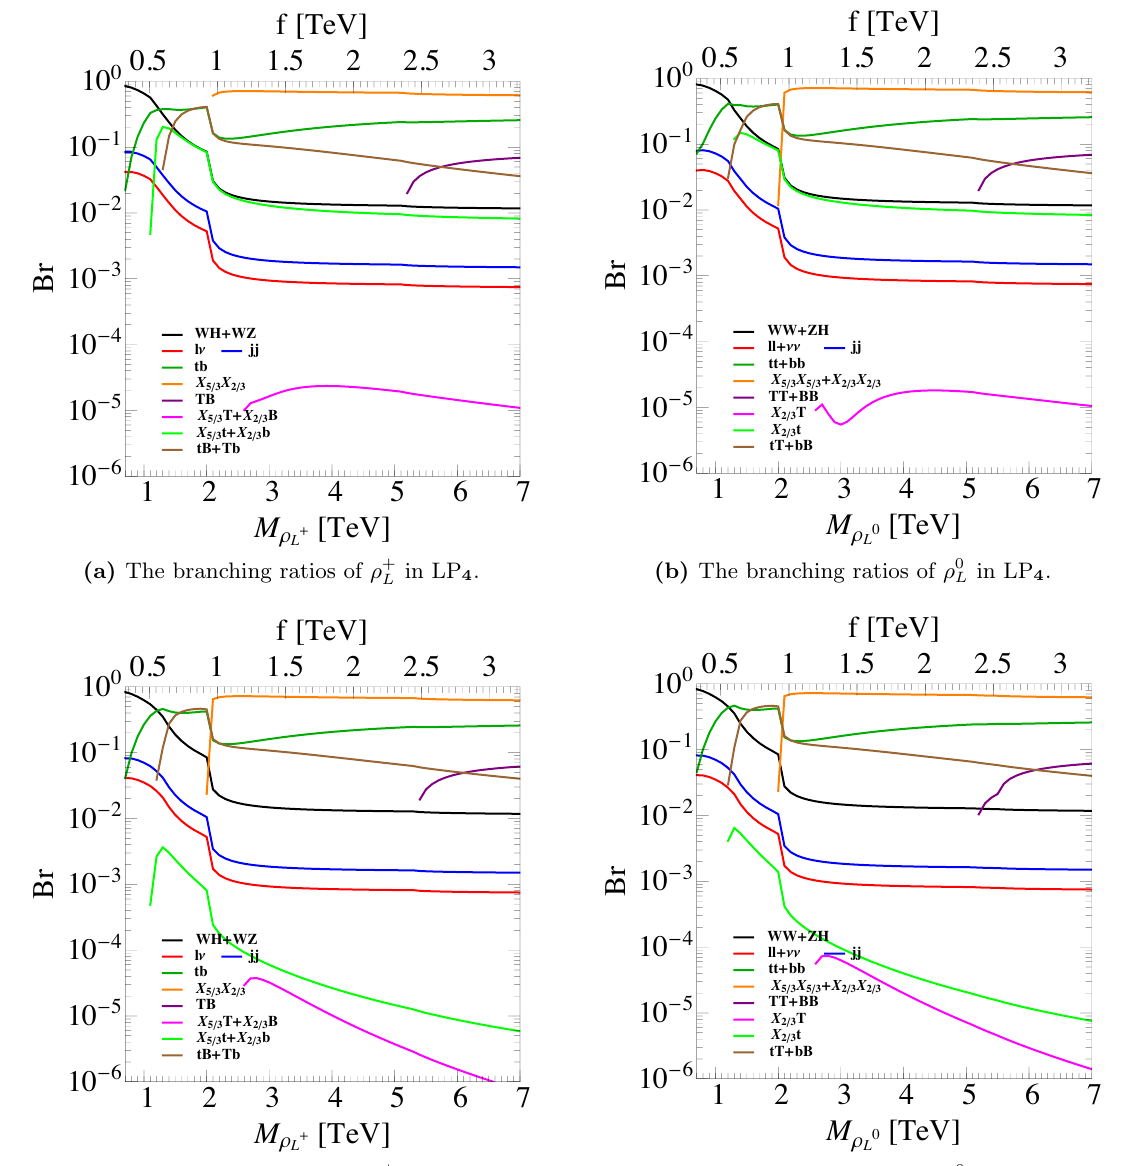
(c) The branching ratios of (cid:26) + Figure 4. The decay branching ratios of the (cid:26) (cid:6) ; 0 a 2 = 1 = 2, M 4 = 1 TeV, y L = 1 and c 1 = 1. For LF 4 there is an additional parameter c 2 = 1. (cid:26) L